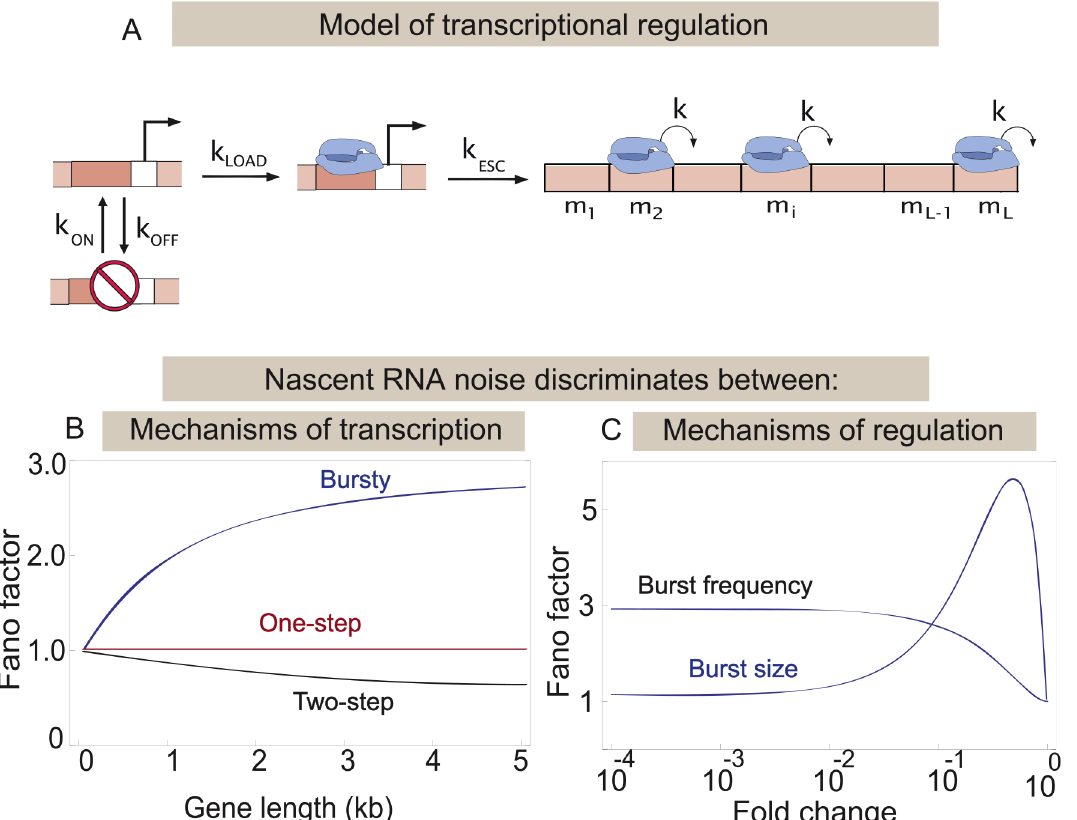
Fig 2. (A) Model of transcriptional regulation. The promoter switches between two states: an active and an inactive one. The probability per unit time of switching from the active state to the inactive state is k OFF , and from the inactive to the active state is k ON . From the active state transcription initiation occurs in two sequential steps: the formation of the pre-initiation complex at the promoter proceeds with rate k LOAD after which the RNA polymerase escapes the promoter at a constant probability per unit time k ESC . Once on the gene the polymerases move from one base pair to the next with a rate k , until they reach the end of the gene and they fall off with the same rate. From this model we compute the mean and the variance of the number of RNA polymerases, present on the gene in steady state, as a function of all the rates and the length of the gene L . This calculation is aided by introducing the m i variables for every base, which keep track of the number of polymerases at that base. (B) Noise profile for different models of transcription initiation. From the master equation of the model described in (A) we computed the Fano factor of the nascent RNA distribution as a function of the length of the gene being transcribed, for the three different models of transcription initiation: one-step (red), "bursty"(blue), and two-step initiation (black). The three different models give qualitatively distinct predictions. To illustrate this point for the "bursting" model we use the following parameters: k OFF = 5/min, k ON = 0.435/min, k = 0.8kb/min, k LOAD = 5/min and = 0/min, which are characteristic of the PDR5 promoter in yeast, as reported in [4]. For the two-step model we use k = 0.14/min, k = 0.14/min, k ESC LOAD ESC k OFF = 0/min, k ON = 0/min, k = 0.8kb/min, characteristic of MDN1 promoter, which we find by analyzing the data reported in [25]. For the one-step model, we use k LOAD = 0.09/min, k ESC = 0/min, k OFF = 0/min, k ON = 0/min, k = 0.8kb/min, which are characteristics of the yeast gene RPB1, obtained by analyzing the data published in [25]. (C) Noise profiles for different regulatory mechanisms. In the "bursting" model of transcription, the transcriptional output can be modulated either by changing the burst size or the burst frequency, which in the model can be achieved by tuning k OFF or k ON . The Fano factor for the nascent RNA distribution obtained from burst size and burst frequency mechanisms of regulation are plotted as a function of the fold change in mean. (i.e., the mean of the distribution normalized by the maximum mean number of nascent RNAs in the cell, which is obtained when there is no transcriptional regulation and the promoter is always active). Clearly the two modes of regulation give qualitatively distinct predictions for the noise profile. (To illustrate this point we use the following parameters: k OFF = 5/min, k ON = 0.435/min, k = 0.8kb/min, L = 4436 bps, k INI = 5/min, which were reported for the PDR5 promoter in yeast